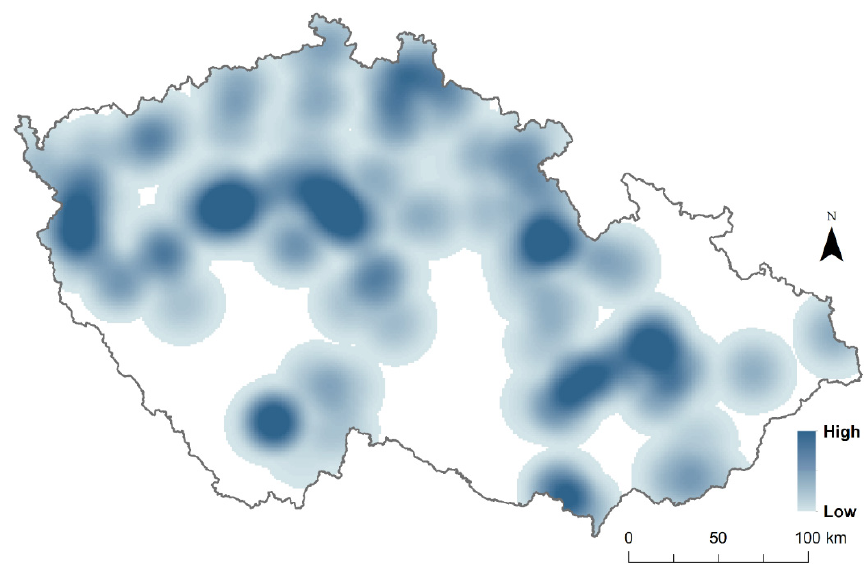
Figure 2. Species richness distribution of five Columbidae species in the Czech Republic with Kernel density interpolation. The darker blue colour represents higher species richness; light blue colour represents lower species richness; white areas are where census transects are missing. The included species are feral pigeon ( Columba livia forma domestica ), stock dove ( Columba oenas ), wood pigeon ( Columba palumbus ), Eurasian collared dove ( Streptopelia decaocto ), and European turtle dove ( Streptopelia turtur ).